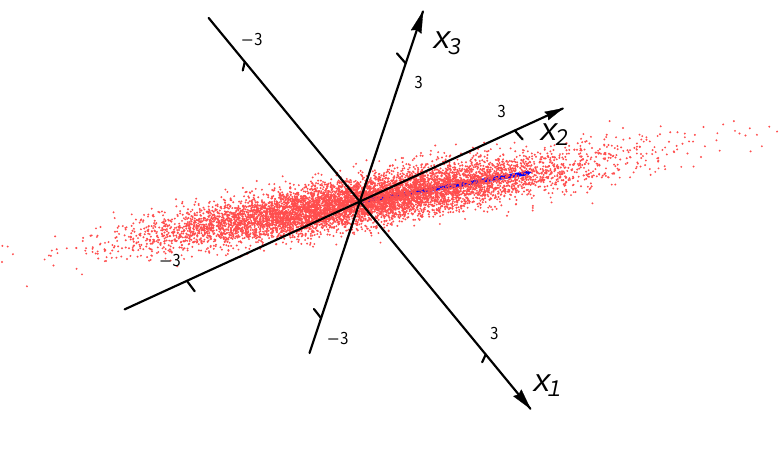
Figure 2. Sample from one Student t